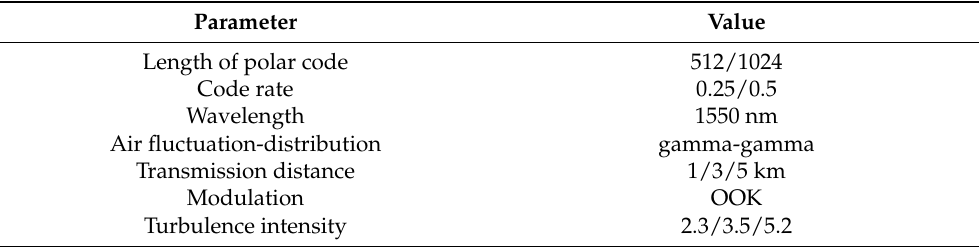
Table 7. Simulation